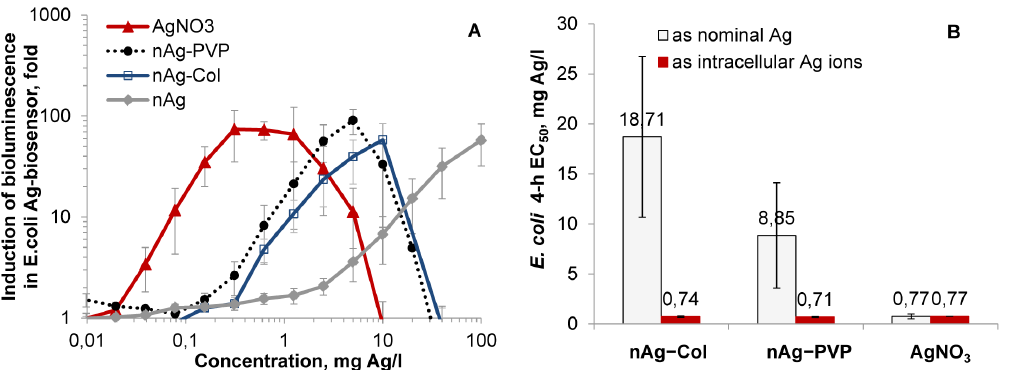
Figure 3. Response of Escherichiacoli MC1061 to silver formulations. A: Dose-dependent induction of bioluminescence of Ag-biosensor E. coli MC1061 (pSLcueR/pDNPcopAlux) in response to silver formulations. The bioluminescence was measured after 4-h exposure (30 u C, half-strength NaCl-free LB medium). The decreased bioluminescence at higher concentrations refers to the toxicity. Concentrations are nominal. B: Toxicity (4-h EC 50 ) of silver nanoparticles and AgNO 3 to E. coli MC1061. EC 50 values based on nominal concentrations (open columns) are from Figure 2; EC 50 values based on intracellular Ag ions (red columns) are re-calculated from Figure 3A. Data represent the average 6 SD